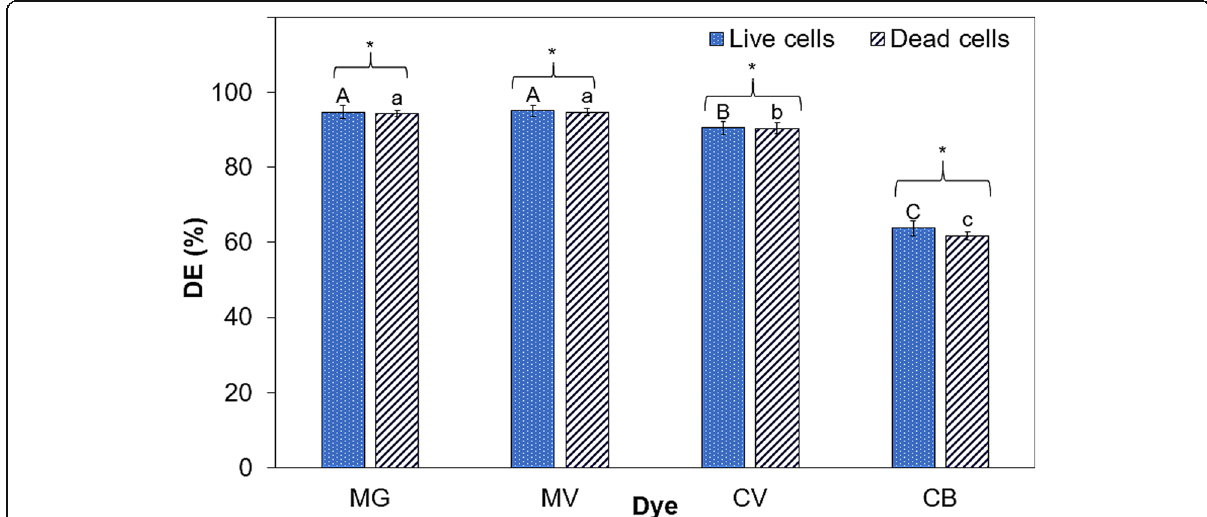
Fig. 2 Comparison of maximum DE by live and dead cells on TPM dyes using non-optimized conditions (biomass dosage 1.0 g, agitation 100 rpm, pH 5, incubation at 30 °C). Means with the same capital letters (live cells) and the same small letters (dead cells) are not significantly different at HSD ( 0.05 ). Bars indicate standard error of mean (± SEM). ‘ * ’ indicates significant difference based on paired T -test ( p < 0.05) between live and